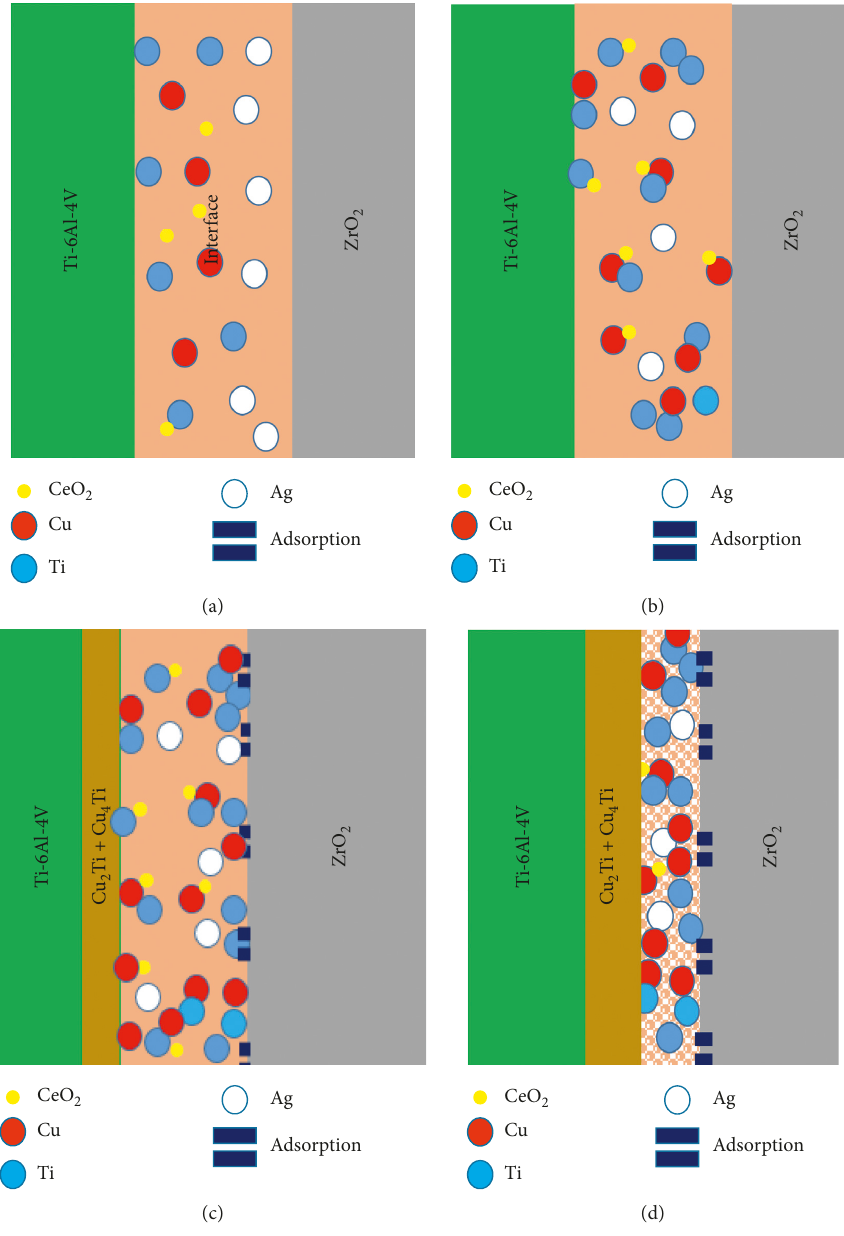
Figure 9: Schematic for joint formation and bonding of the ZrO Table 4: Microhardness values of composite fillers as a function of CeO Serial